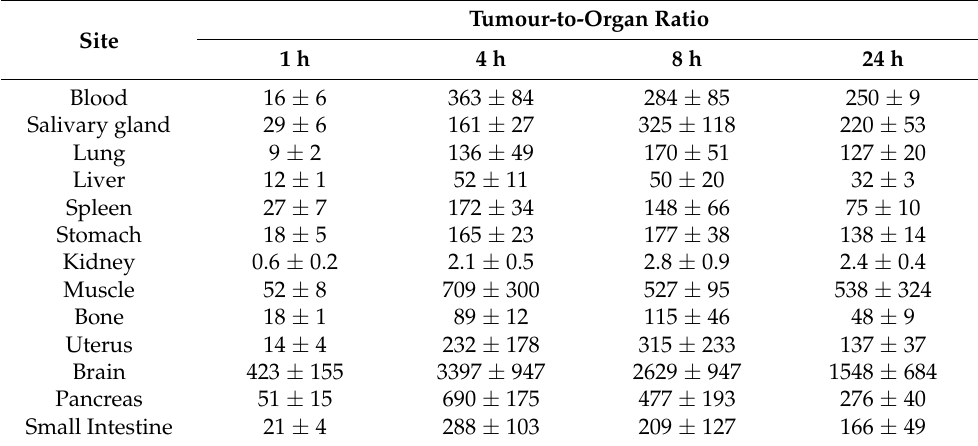
Table 4. Tumour-to-organ ratios for [ 99m Tc]Tc-ZHER2:41071 in BALB/C nu/nu mice bearing SKOV3 xenografts. Data are expressed as %ID/g and are averages from four mice ±